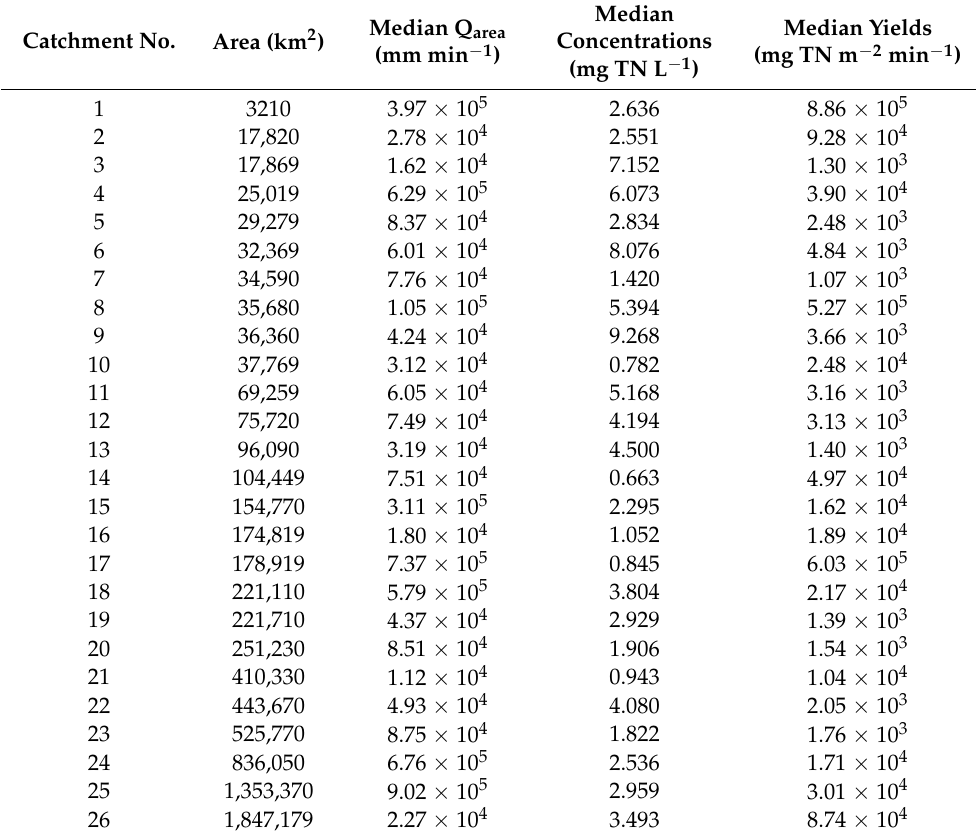
Table 3. Catchment area, Q area , TN concentrations, and TN yields of the study